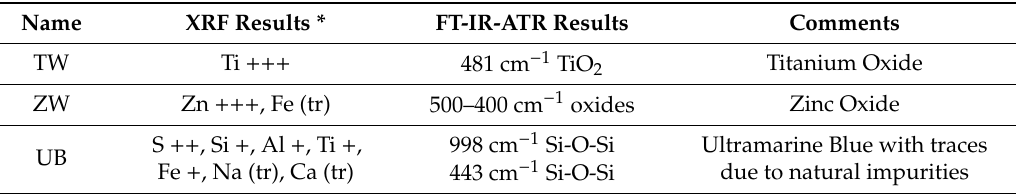
Table 2. XRF and Fourier Transformed Infrared Attenuated Total Reflectance (FT-IR-ATR) results on the powdered